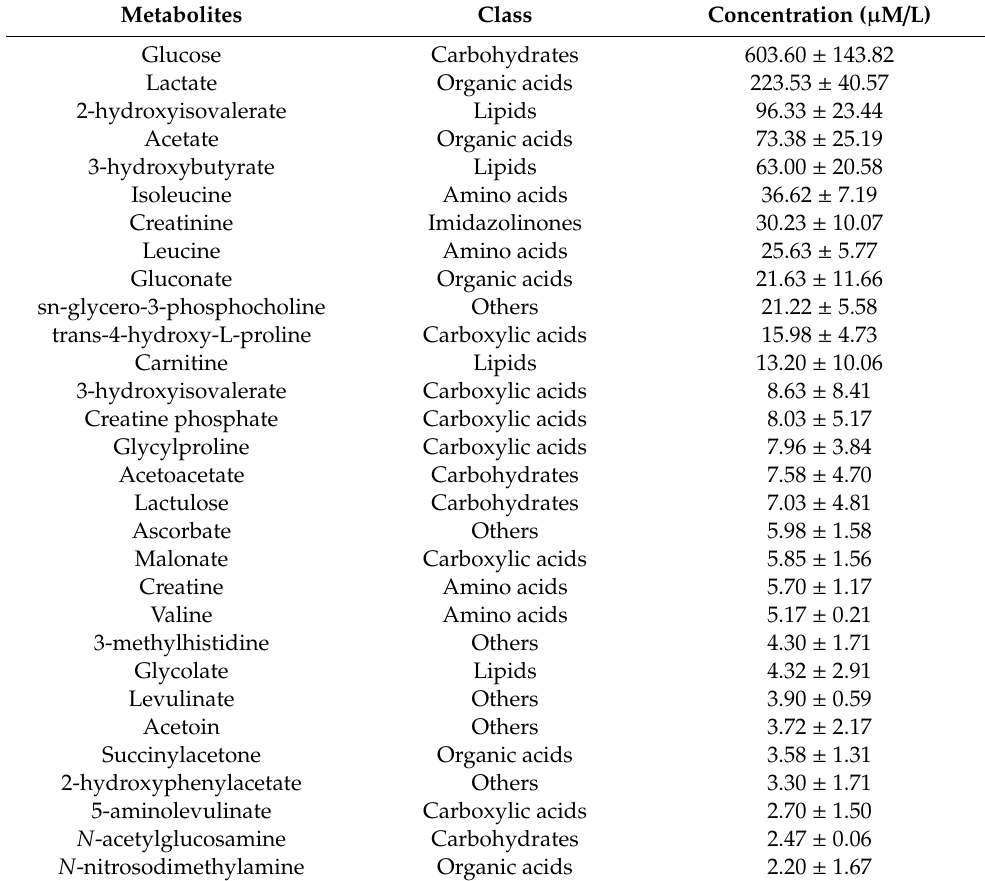
Table 2. Top 30 concentration (mean ± standard deviation) of metabolites quantified ( n ≥ 4) in serum by 1 H-NMR spectroscopy of Hanwoo